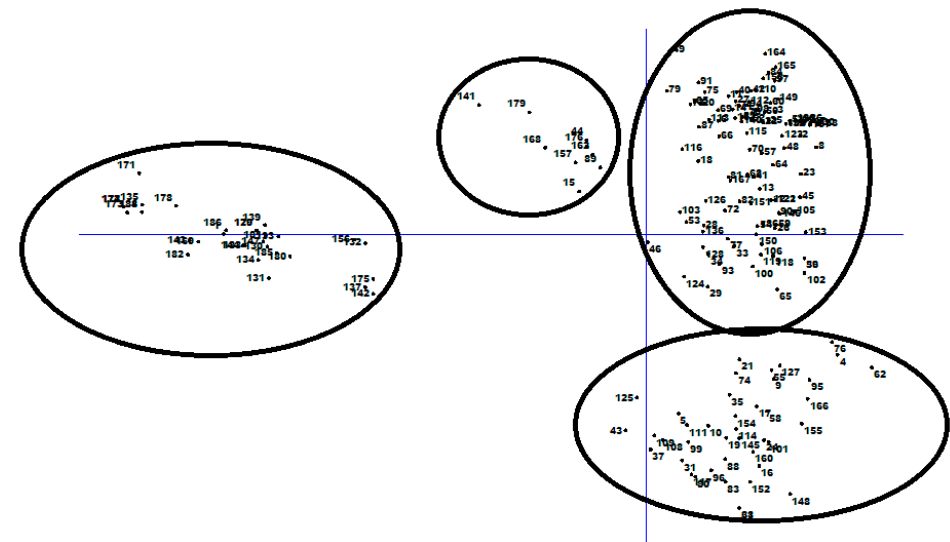
Figure 6. Principal coordinate analysis of 186 chickpea genotypes based on DArTseq-SNP markers.